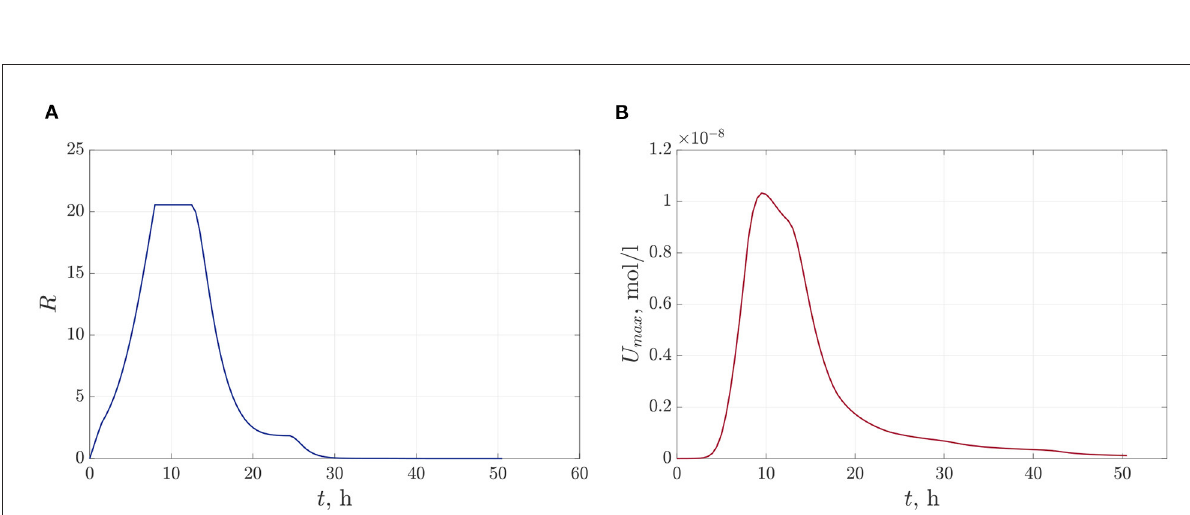
antibiotic treatment was done three times, specifically at 12,